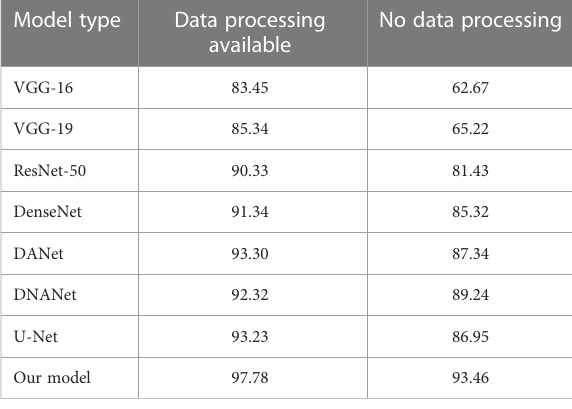
TABLE 5 Results of different data processing runs on each model.